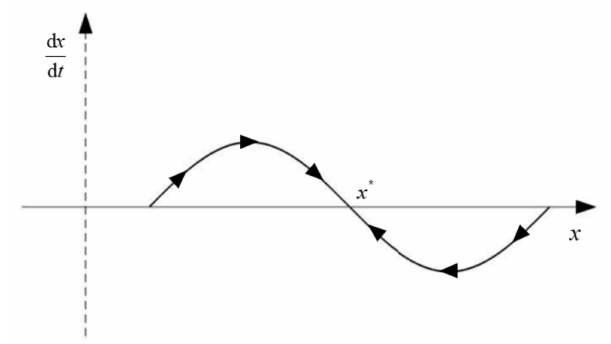
Figure 2. Phase diagram of duplicative dynamic